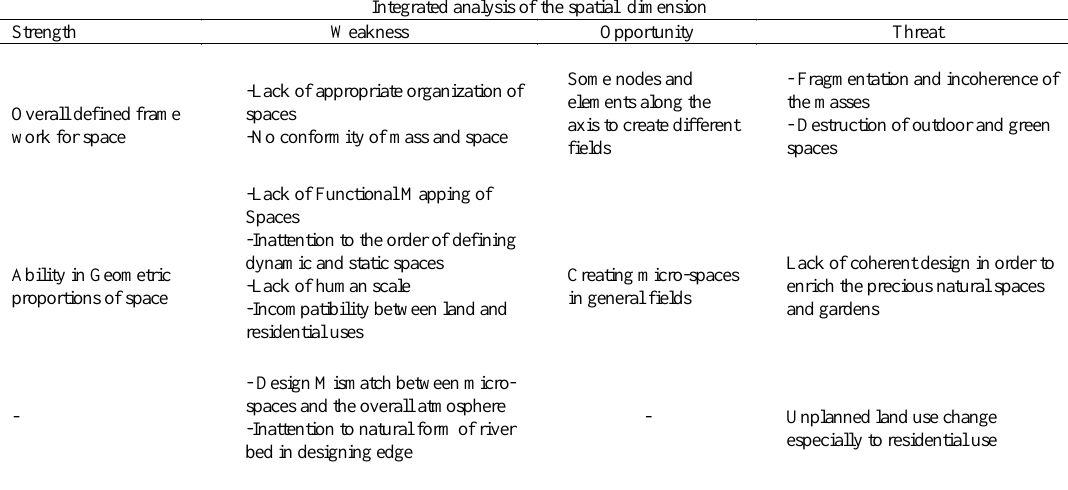
Table 2: Integrated analysis of the spatial dimension of the Khoshk